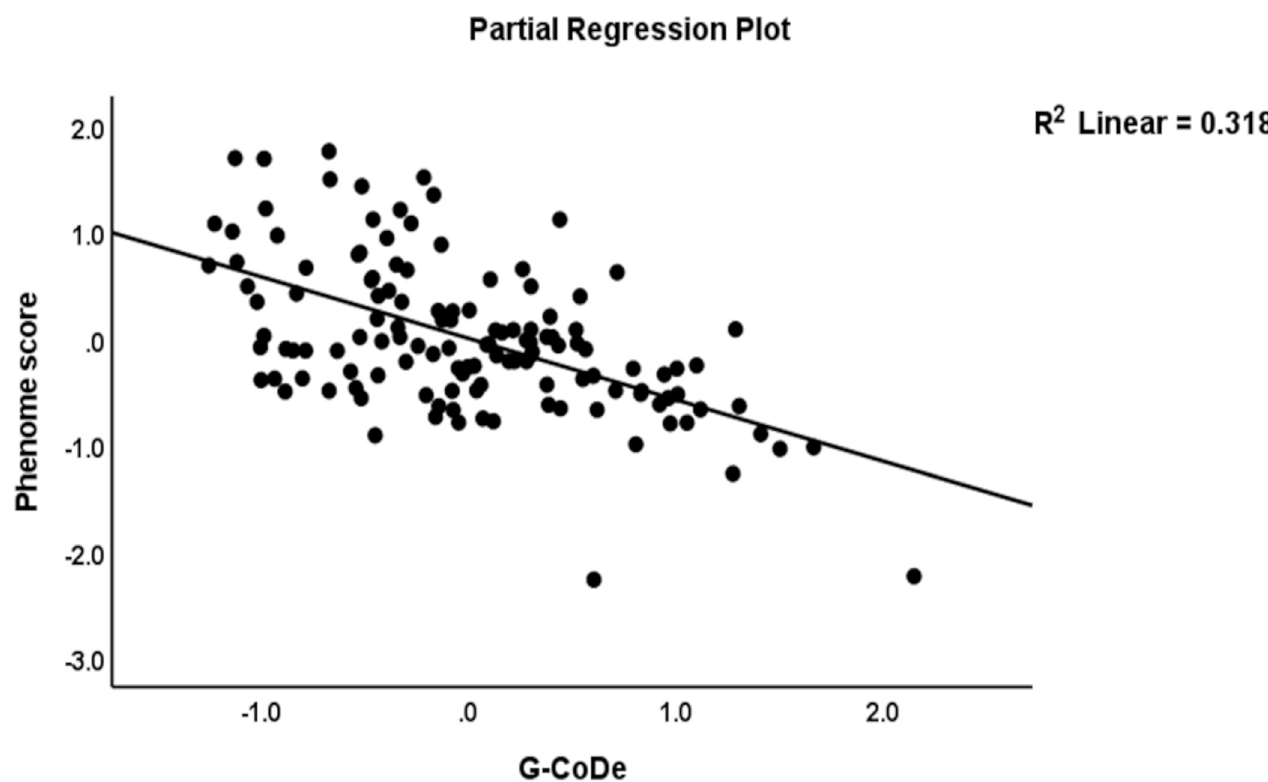
Fig 2. Partial regression plot of the phenome of schizophrenia on the generalized cognitive decline (G-CoDe) score.